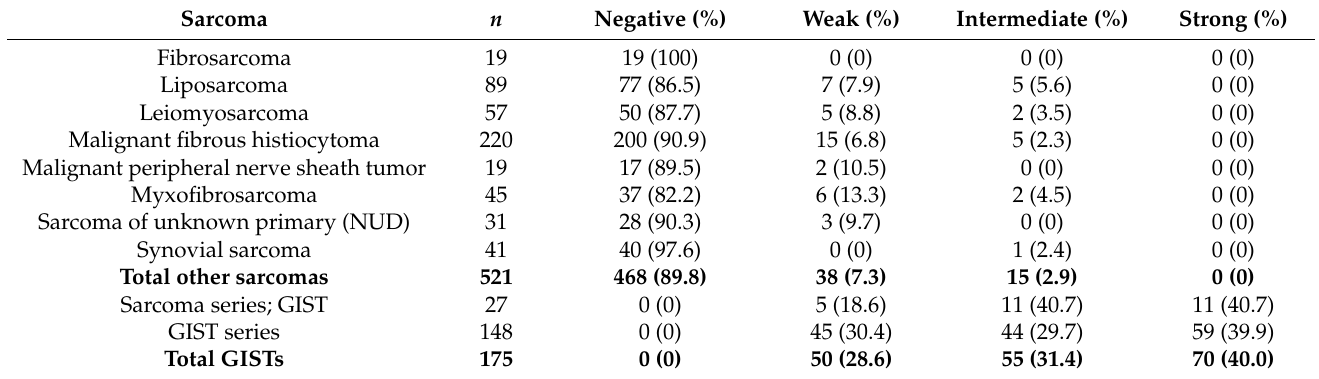
Figure 2. Representative images of TNS2, KIT, and DOG1 immunohistochemical stainings in GIST TMA samples, graded as negative (−), weak (+), intermediate (++), and strong (+++) (from top to bottom). None of the TMA spots stained negative for TNS2. The pictures are 400× magnifications of the TMA samples. Scale bars in the lower left corners are 40 µm. Table 3. TNS2 immunohistochemical expression in 175 GISTs and 521 other soft tissue sarcomas, graded as negative, weak, intermediate, or strong